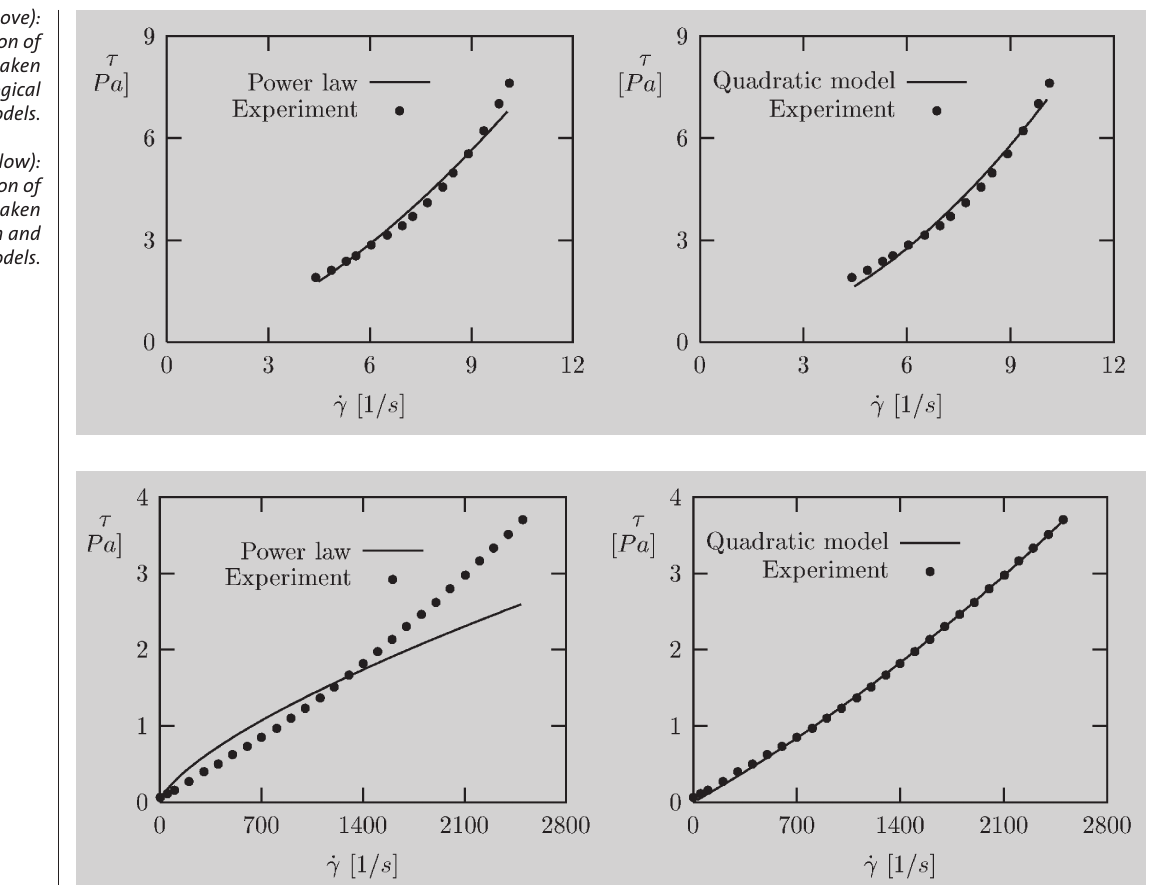
Figure 3 (above): Comparison of experimental data taken from Steffe and rheological models. Figure 4 (below): Comparison of experimental data taken from Ebadian and rheological